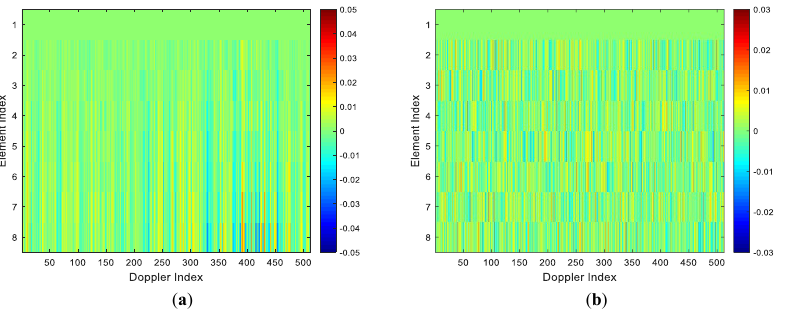
Figure 9. The amplitude differences and phase differences between the estimated spatial steering vectors and true spatial steering vectors (all Doppler bins). ( a ) Amplitude differences; ( b ) Phase differences.